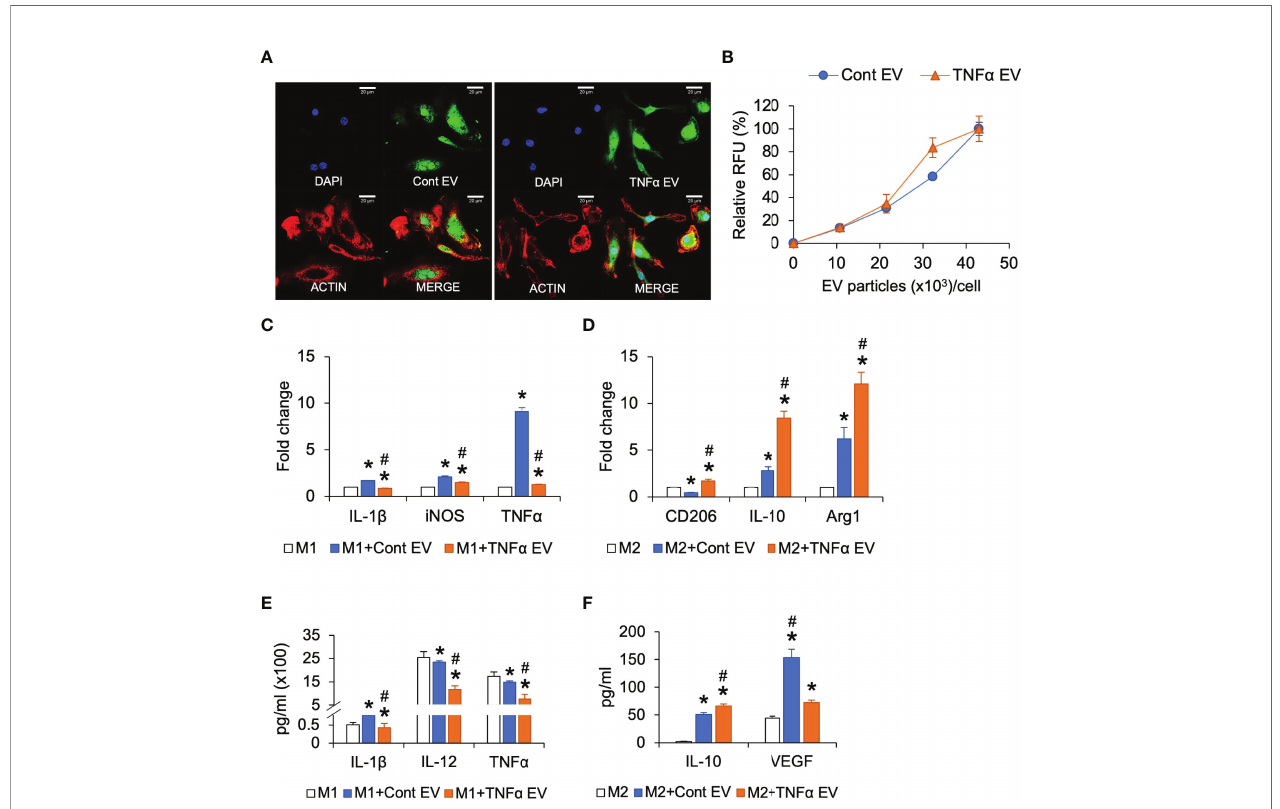
FIGURE 3 | Effect of TNF a EVs on macrophage polarization. (A) Representative confocal images of fl uorescently labeled control and TNF a EVs (green) endocytosed by macrophages. Scale bar=20 m m in all images. The red staining in the images indicate actin counter stain and blue staining shows the nuclei (DAPI). (B) Dose- dependent endocytosis of fl uorescently labeled control and TNF a EVs by primary macrophages. (C) Fold change in gene expression of pro-in fl ammatory markers in M1 polarized macrophages in the presence/absence of EVs. Note that TNF a EVs signi fi cantly reduce the expression levels of IL-1 b , iNOS and TNF a indicating a reduction in M1 polarization. (D) Fold change in the expression levels of M2 marker genes in M2 polarized macrophages in the presence/absence of EVs. Note the signi fi cant increase in the expression levels of M2 markers CD206, IL-10 and Arg1 indicating an increase in M2 polarization. (E) Multiplex ELISA determined quantitative expression of pro-in fl ammatory cytokines in M1 polarized macrophages in the presence/absence of EVs. Note the signi fi cant reduction in cytokine expression in the presence of TNF a preconditioned MSC EVs. (F) Multiplex ELISA determined quantitative expression of IL-10 and VEGF in M2 polarized macrophages. *: statistical signi fi cance (P < 0.05) with respect to untreated control, #: represents statistical signi fi cance (P < 0.05) between control and TNF a EV groups as calculated by Tukey ’ s test post